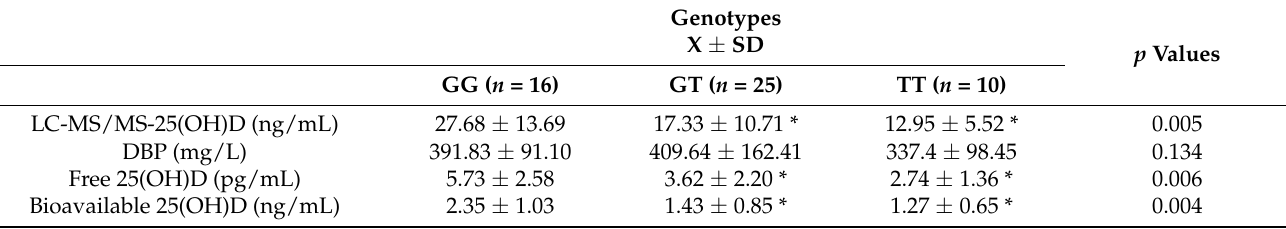
Table 1. Comparison of vitamin D parameters within the three genotype cohorts of individuals with the rs7041 polymorphism.